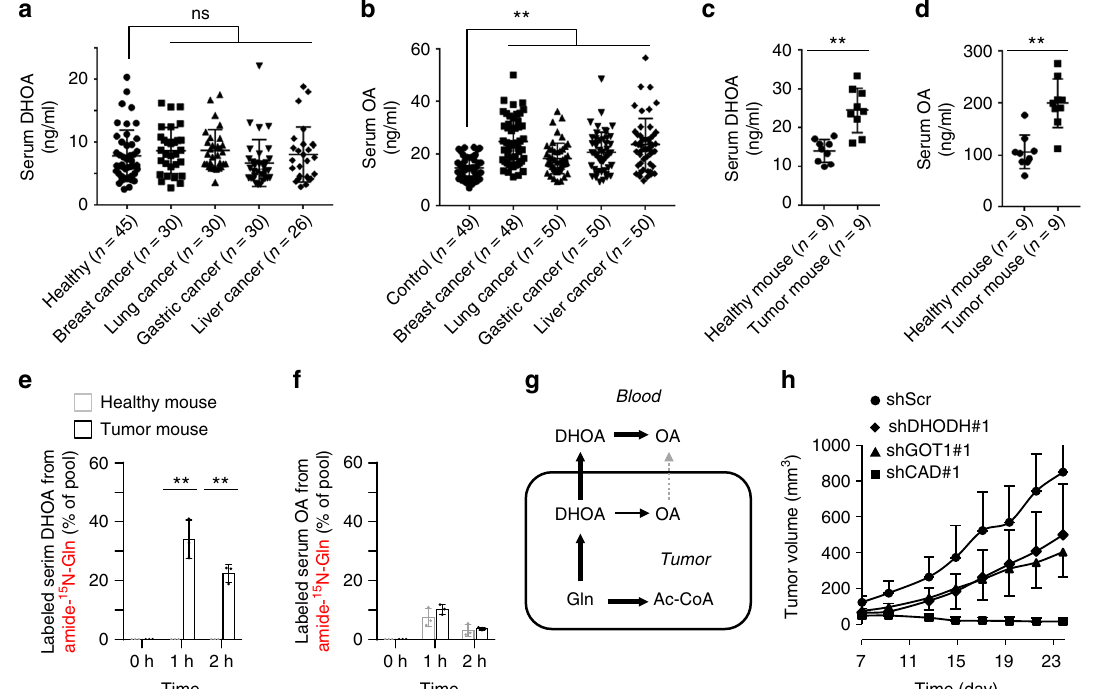
Fig. 7 Glutamine-derived dihydroorotate is required for tumor growth. a , b Serum dihydroorotate and orotate in healthy controls and cancer patients. c , d Serum dihydroorotate and orotate in healthy and HeLa-derived tumor-bearing nude mice. e , f The 15 N-labeled fraction of blood dihydroorotate and orotate in healthy and HeLa-derived tumor-bearing nude mice intraperitoneally injected with 5 mmol kg − 1 of amide- 15 N-glutamine for 1 or 2 h. Values are the means ± SEM of data from three mice. g Tumors directly excreted dihydroorotate that was oxidized to orotate in blood. h The in vivo tumor growth of HeLa/shScramble, HeLa/shDHODH, HeLa/shCAD, and HeLa/shGOT1 cells. * p < 0.05; ** p < 0.01 (Student ’ s t -test) 10 NATURE COMMUNICATIONS| (2019) 10:201